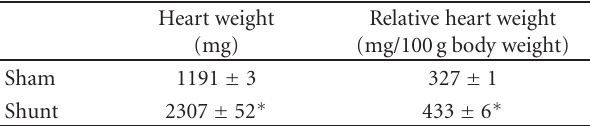
Table 1: Heart weights of sham-operated control and shunted vol- ume-overloaded rats.